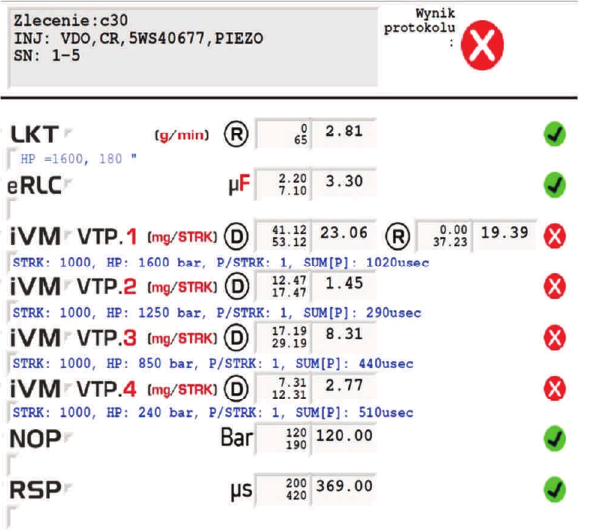
Fig. 2. The protocol of research fuel injector on Zapp CRU 2i test bench